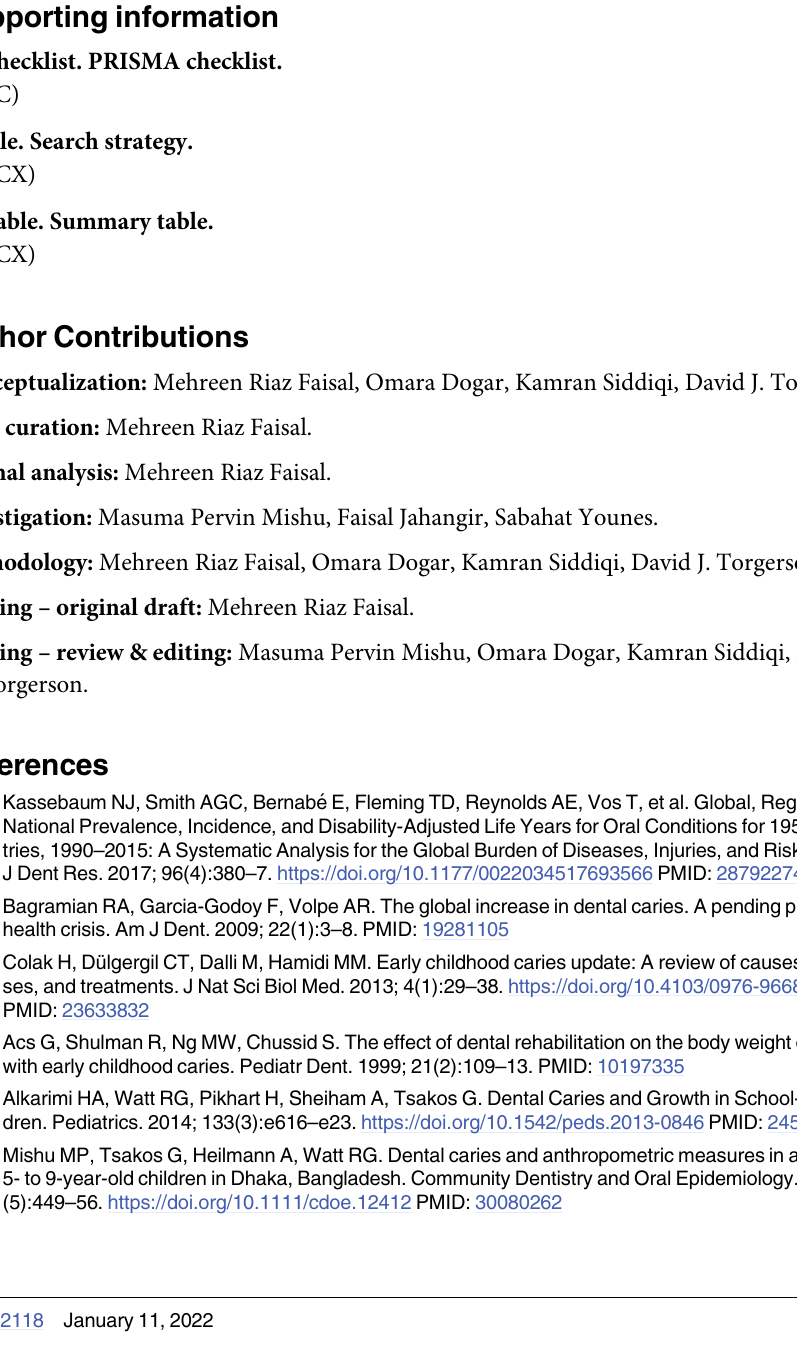
S1 Table. Summary